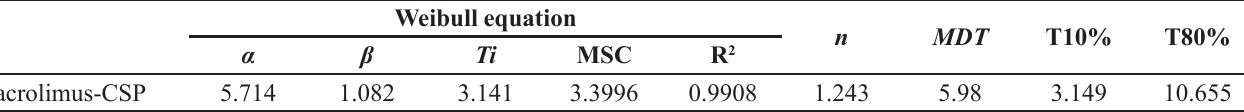
TABLE IV - Release kinetics of optimized